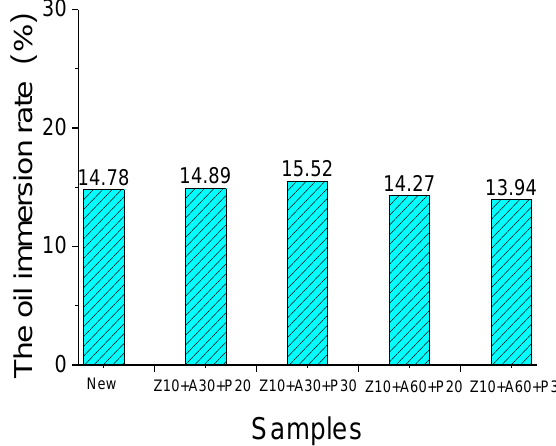
Figure 10. The immersion rate of the untreated insulating pressboard and modified insulating pressboard.